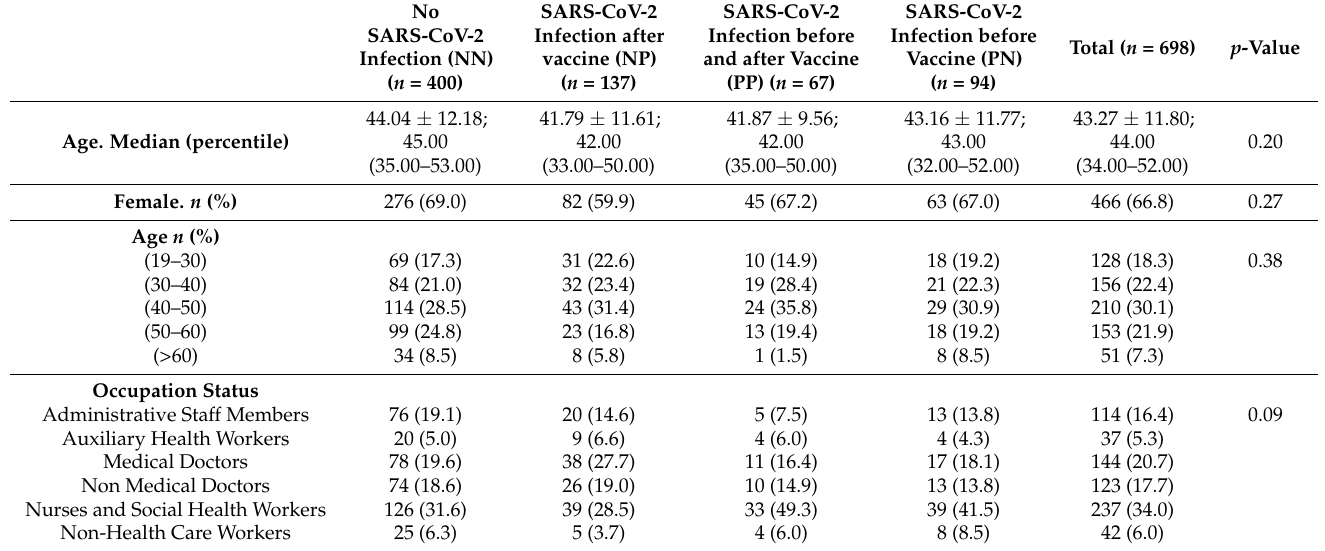
Table 1. Population